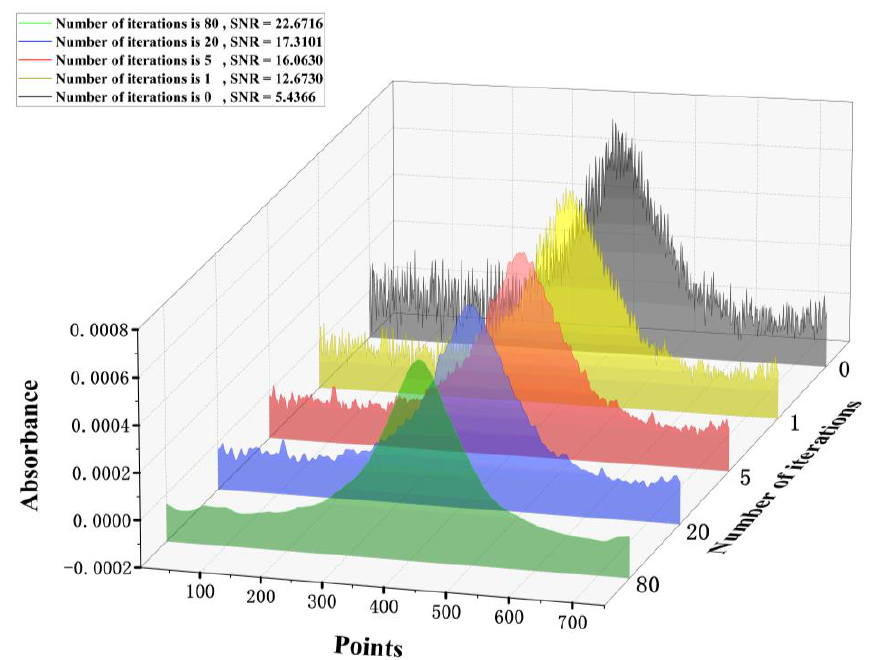
Figure 6. The result of 1 ppm CH 4 original spectra processing with improved particle swarm algorithm. The number of iterations is 0 (black), 1 (yellow), 5 (red), 20 (blue), and 80 (green).